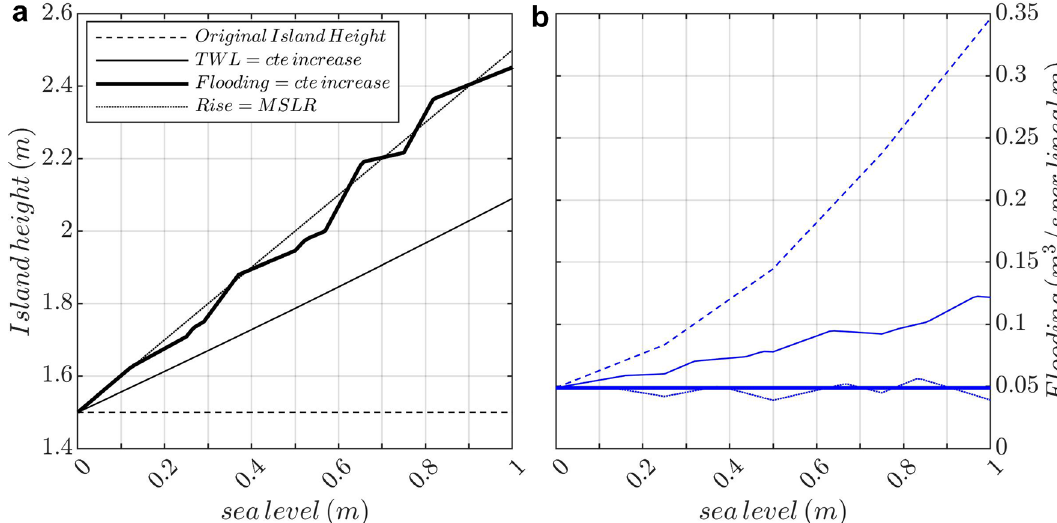
Figure 5. Evolution of the island height ( a ) and flooding ( b ) with projected mean sea level for an archetypal island with 1.5 m of height, 400 m of reef length (Manning coefficient of 0.1) affected by waves with a 4 m of H s and 20 s of T p for different approaches of adaptation: no adaptation (keeping the initial island height, dashed lines), increasing the island to keep the total water level (mean sea level + wave setup) constant (thin lines), and increasing the island to keep the flooding constant (thick